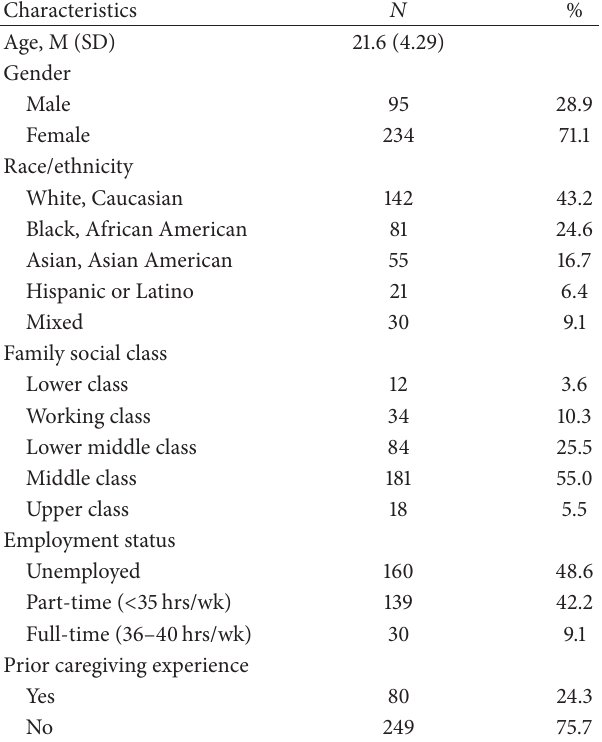
Table 1: Summary of participant